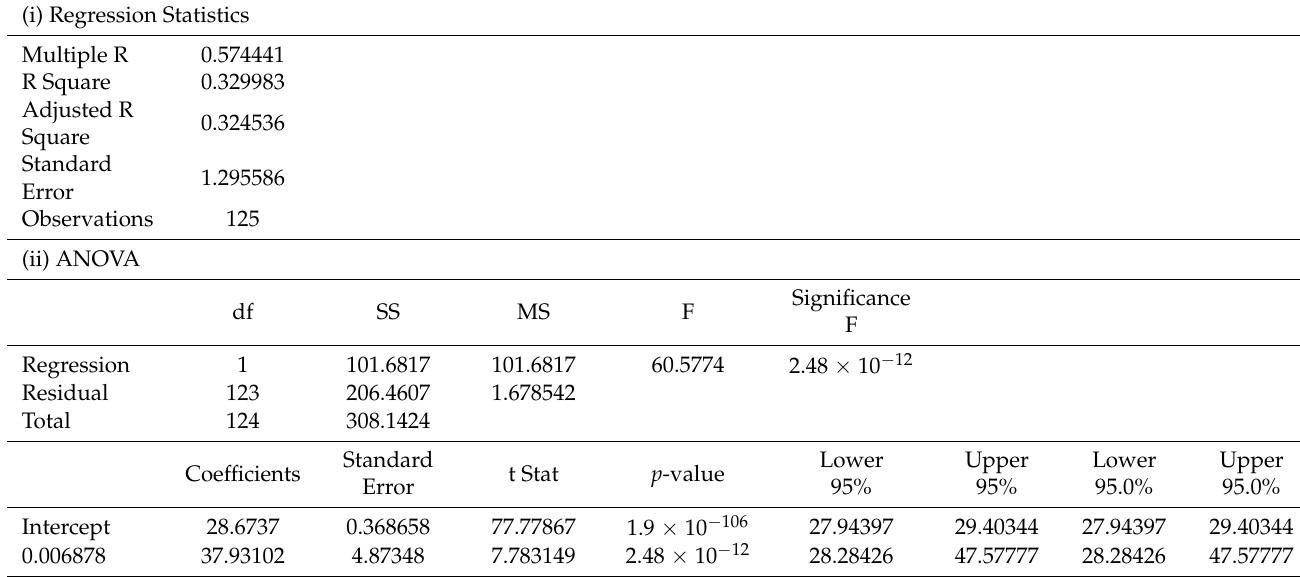
Table A9. Regression Statistics between LST and NDBI for